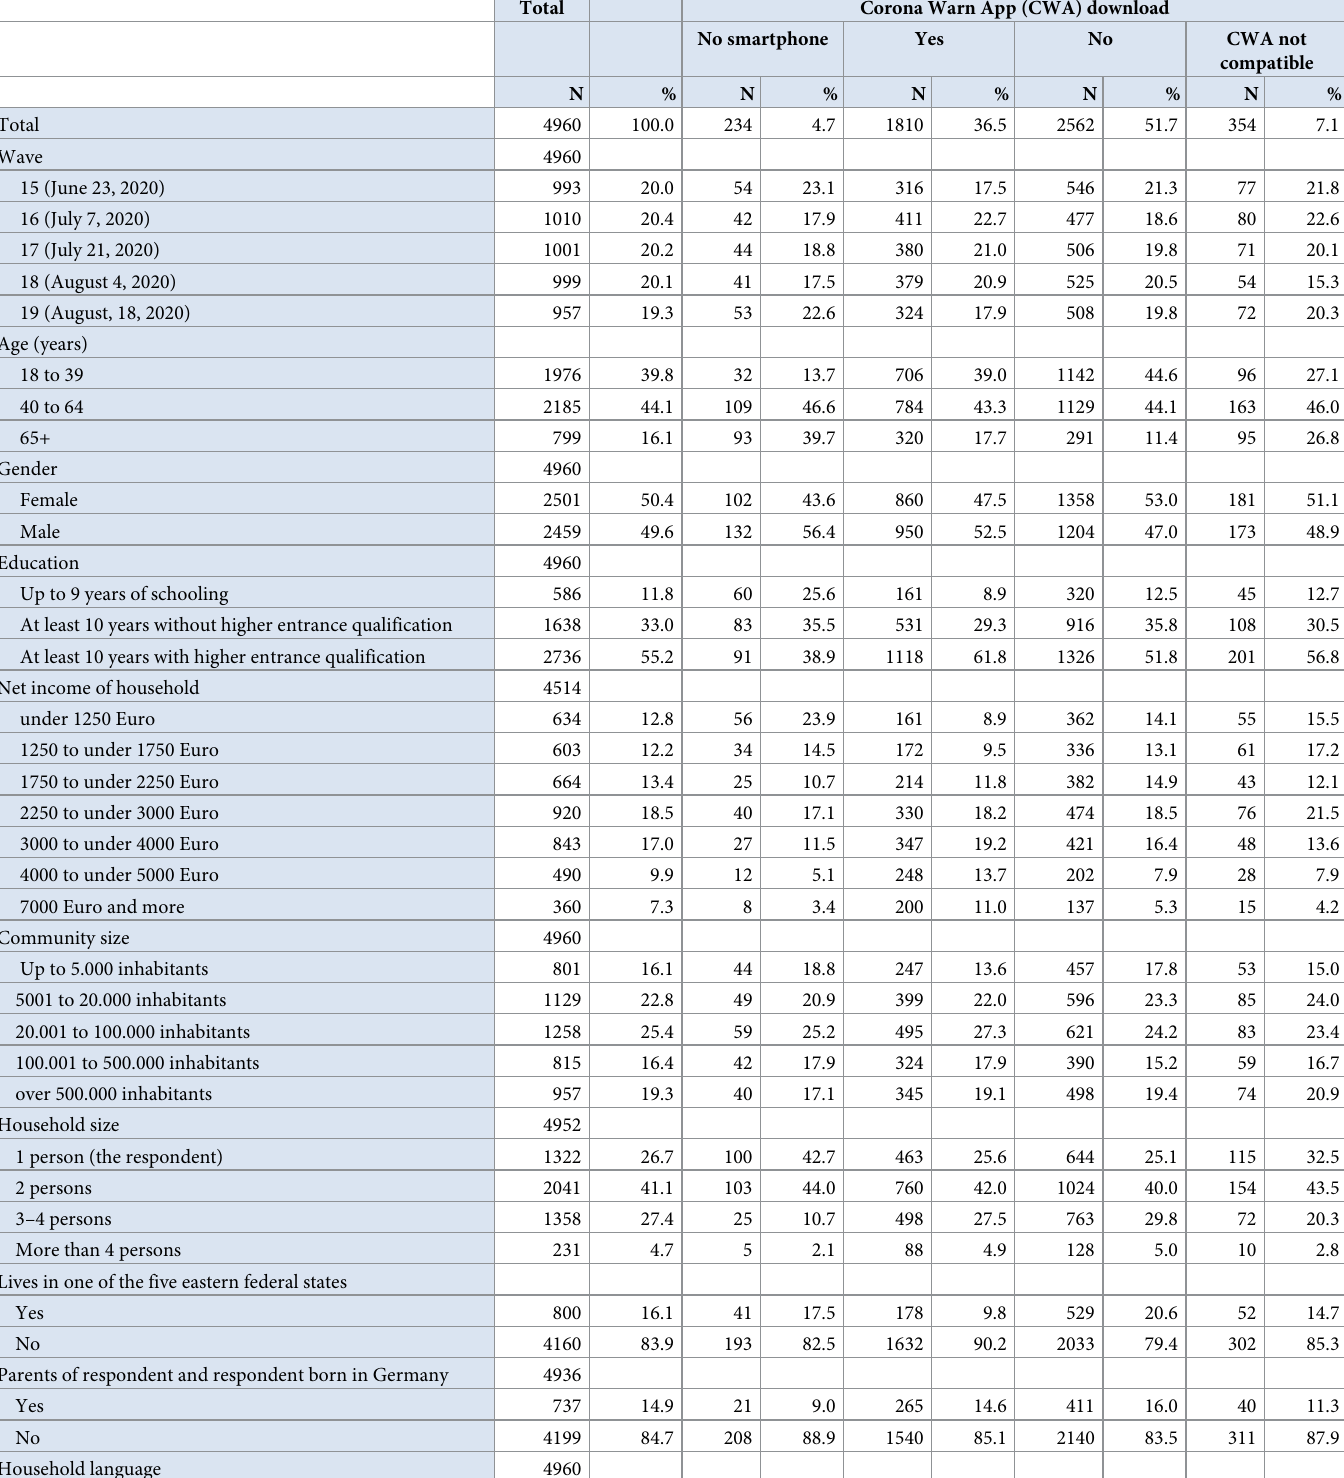
Table 1. Participants’ sociodemographic characteristics of wave 15 to 19 of the COVID-19 Snapshot Monitoring (COSMO) surveys.